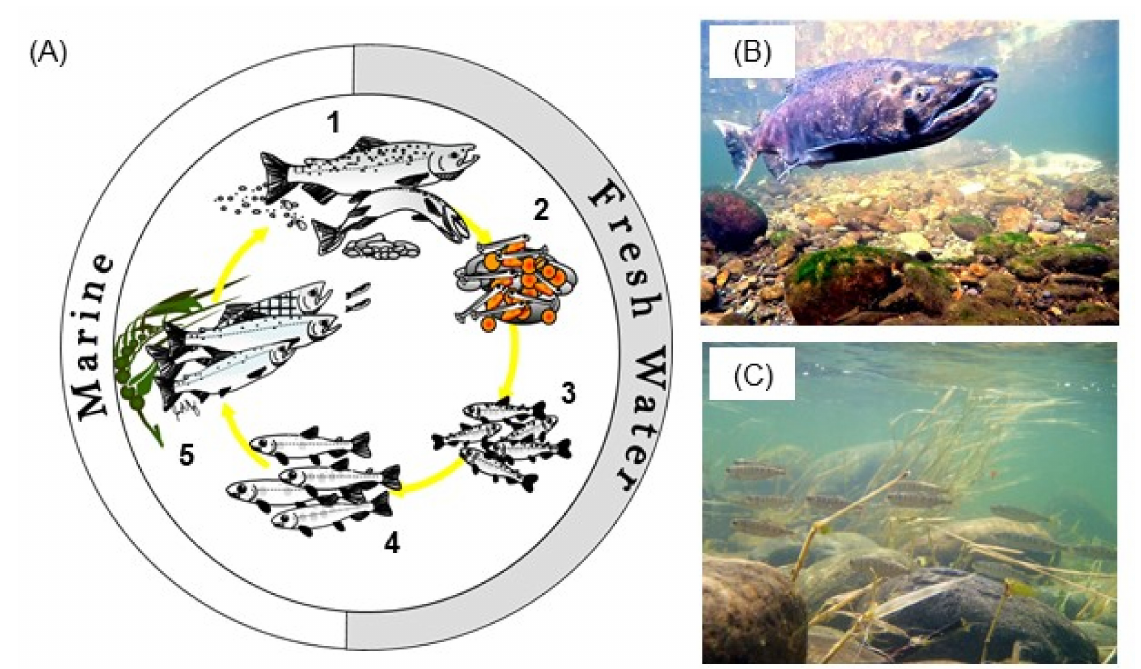
Figure 1. Fall-run Chinook salmon ( Oncorhynchus tshawytscha ) life cycle ( A ) and utilization of freshwater habitat features for spawning ( B ) and rearing ( C ). Salmon are anadromous, spawning and rearing in freshwater before migrating to ocean waters. After several years in the ocean salmon migrate to the gravel–cobble bedded reaches of natal rivers to spawn (1) in alluvial features such as riffles and pool tail outs ( B ) [17]). To spawn a female digs a redd in the riverbed and releases her eggs while one or more males release sperm. Photograph B shows a Chinook salmon in the process of selecting a redd. The female then buries the nest with gravels. Eggs incubate (2) over several weeks depending on benthic environmental conditions. After emergence from the redd, fry (3) feed for several months on invertebrates within the river. As fry grow, they transition into stream feeding juvenile salmon (4) and use geomorphic features including channel margins, side channels, floodplains, and other off-channel habitat types. For example, photograph ( C ) shows juvenile Chinook salmon rearing along the margins of a side channel. Juvenile salmon ultimately begin migrating down the river corridor undergo smoltification as they travel to downstream estuaries and the ocean (5). The graphic in ( A ) is courtesy of Joseph Merz. Photo ( B ) is courtesy of Kyle Horvath and ( C ) is courtesy of Jesse